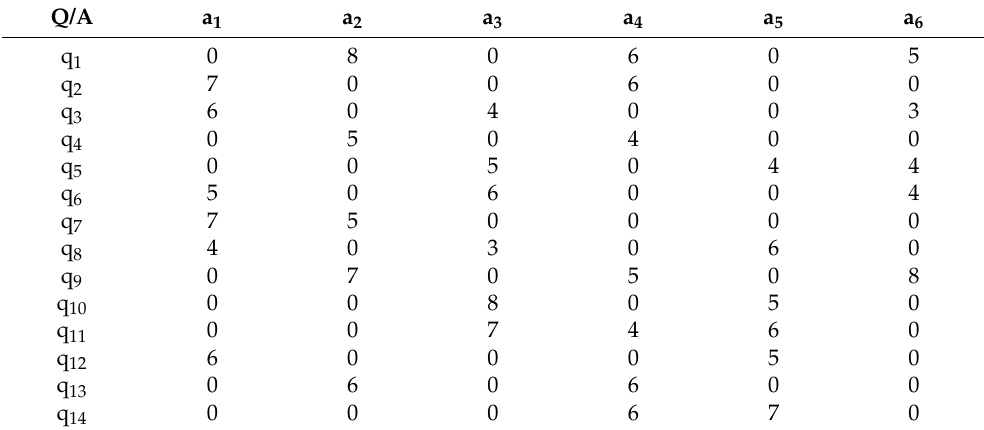
Table 4. Modified competency matrix. Q/A